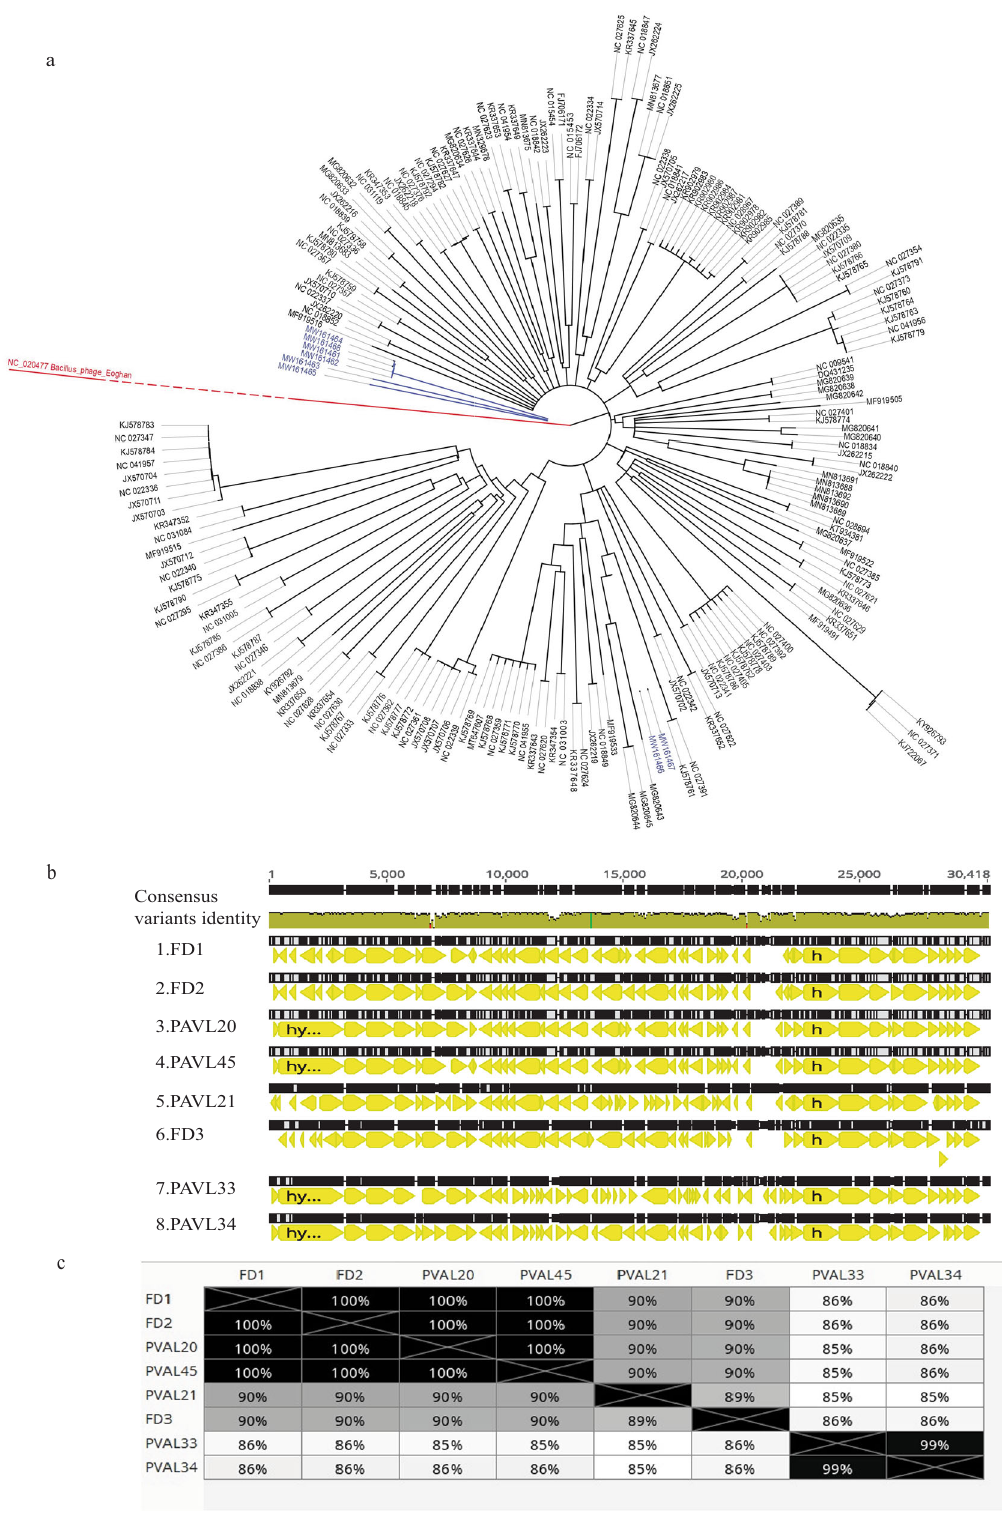
b Alignment of genomes of the eight isolated phages. c Distance table of the percentage of identity of phages. b , c were created using the Genious Prime 2022.2.1